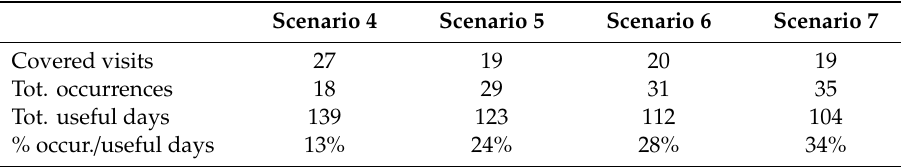
Table 6. Adding overtime parameters to scenario 4–7 as “covered